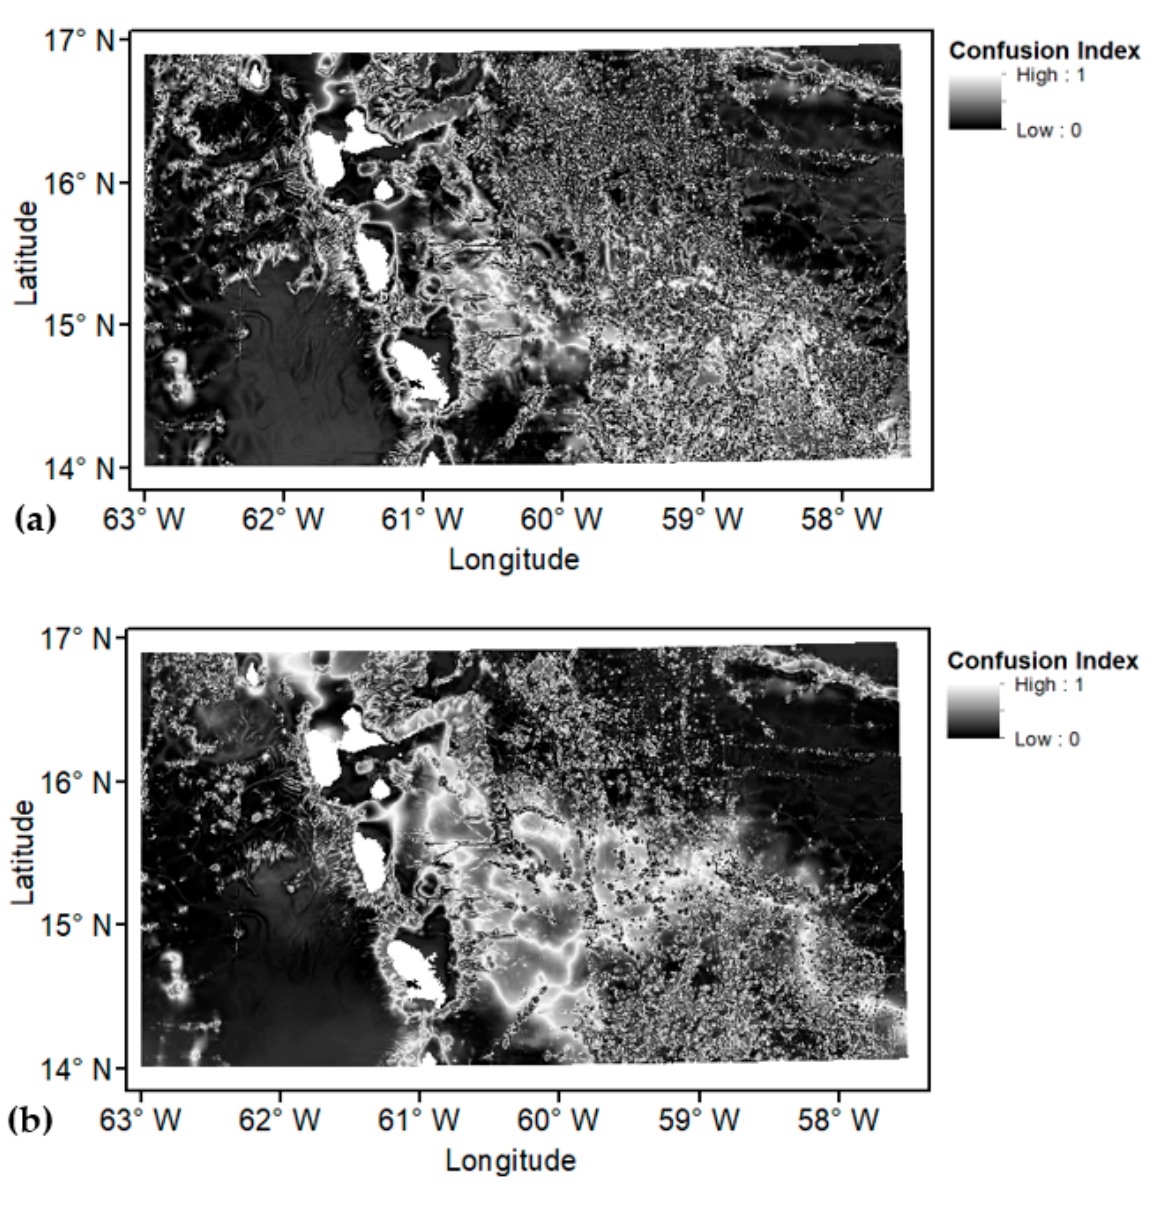
Figure 9. Confusion Index Map. Showing quantified clustering uncertainty for the larger study area ( a ) E3 and ( b ) E4. Zones of high confusion appear white, while lower confusion is darker.